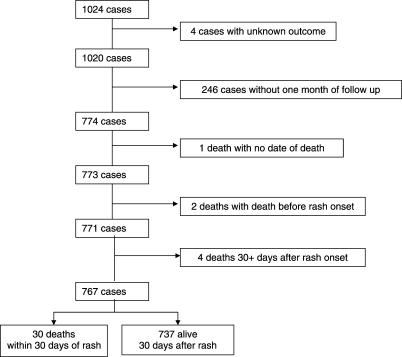
Flow Diagram of Measles Cases Included in the Study, Boukoki, Niamey, Niger (2003–2004)